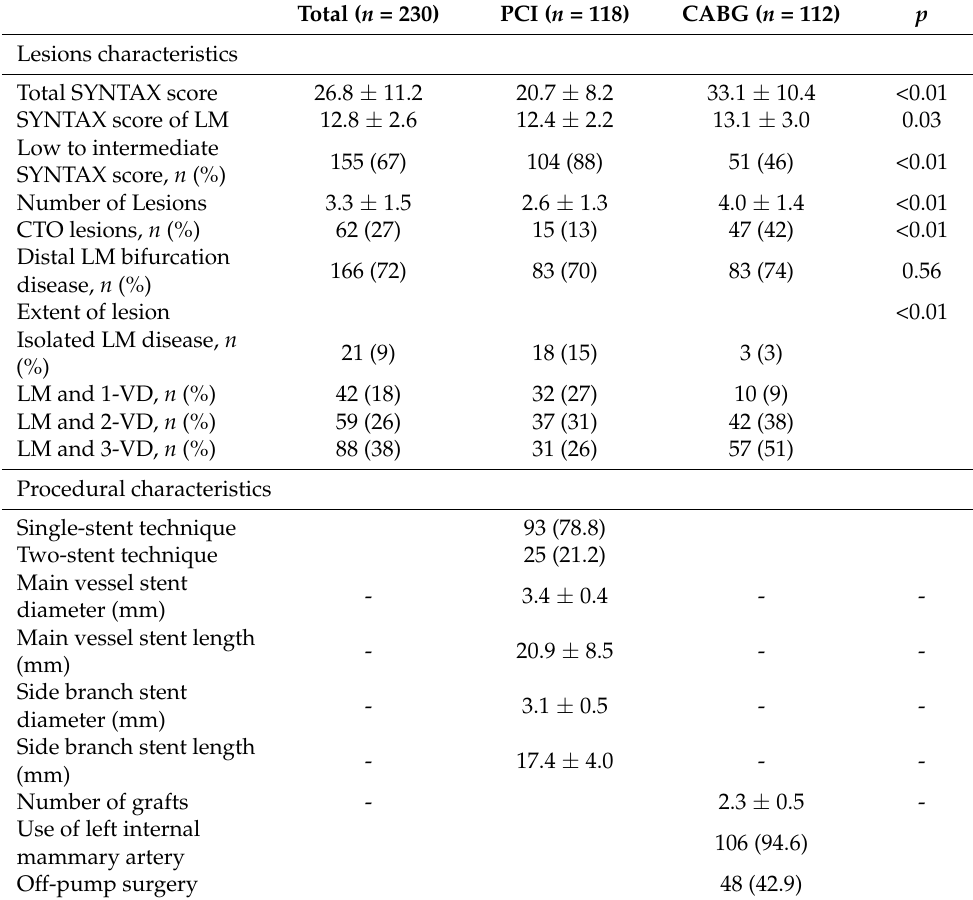
Table 2. Baseline lesions